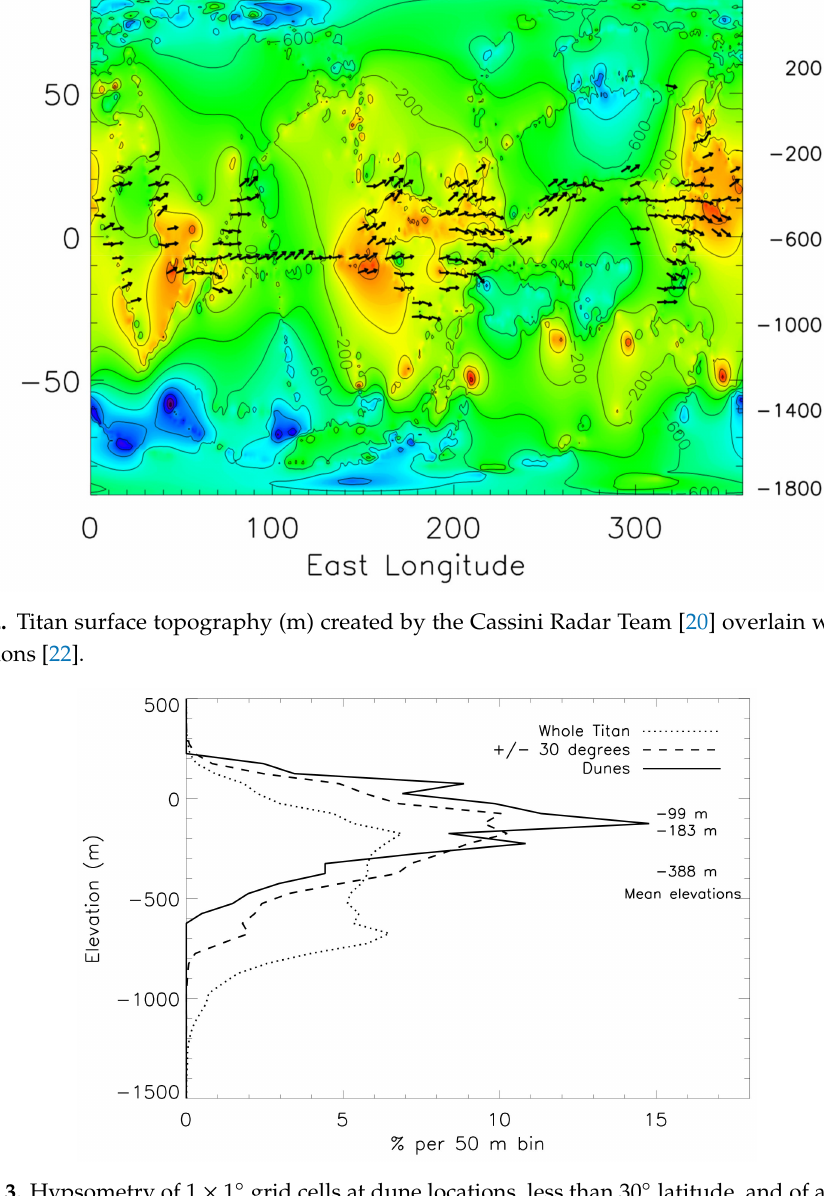
Figure 3. Hypsometry of 1 × 1 ◦ grid cells at dune locations, less than 30 ◦ latitude, and of all